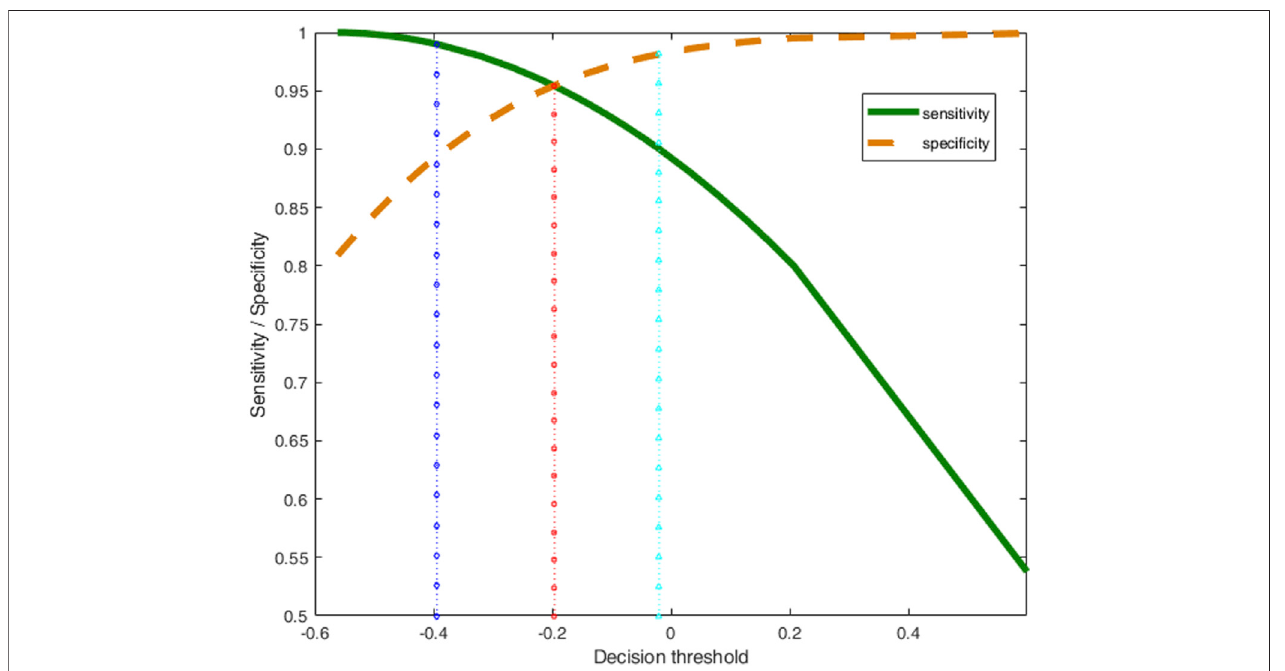
FIGURE 1 | Sensitivity (green thick line) and speci fi city (brown dashed line) of the class-model of ‘ acceptable ’ wines as a function of the decision threshold. The dotted vertical lines mark the decision thresholds for obtaining different class-models in terms of their sensitivity and speci fi city.